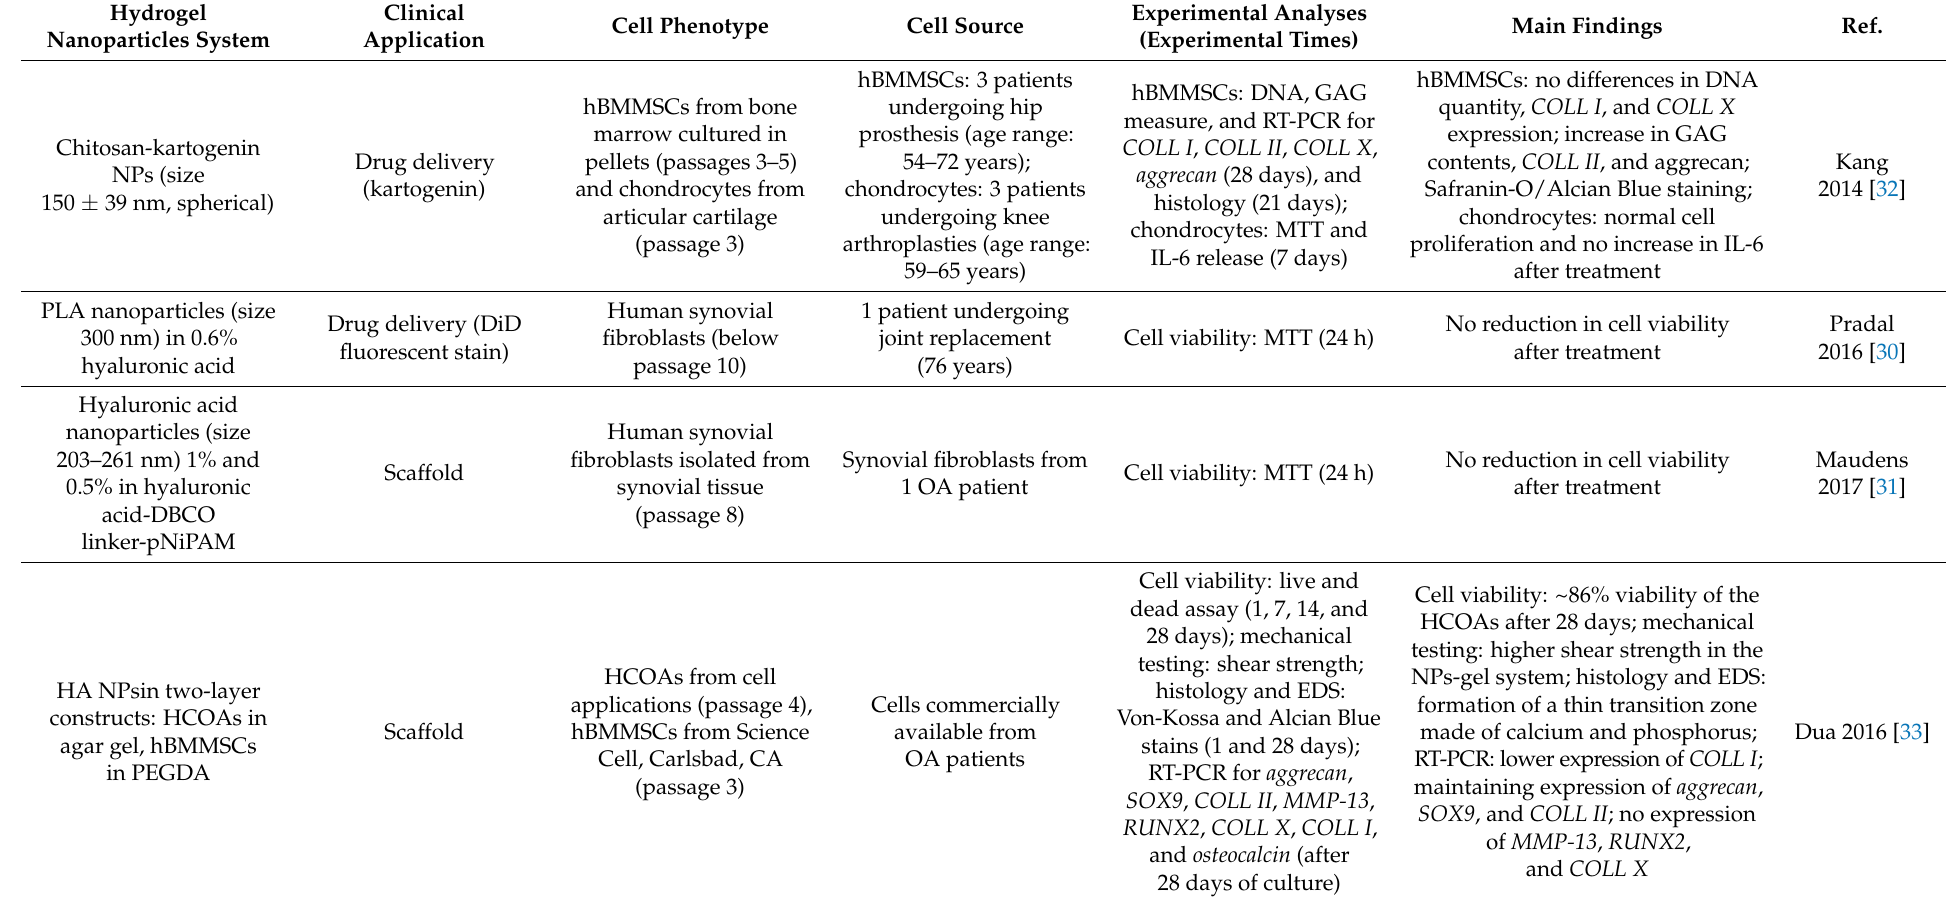
Table 1. Summary of the in vitro preclinical